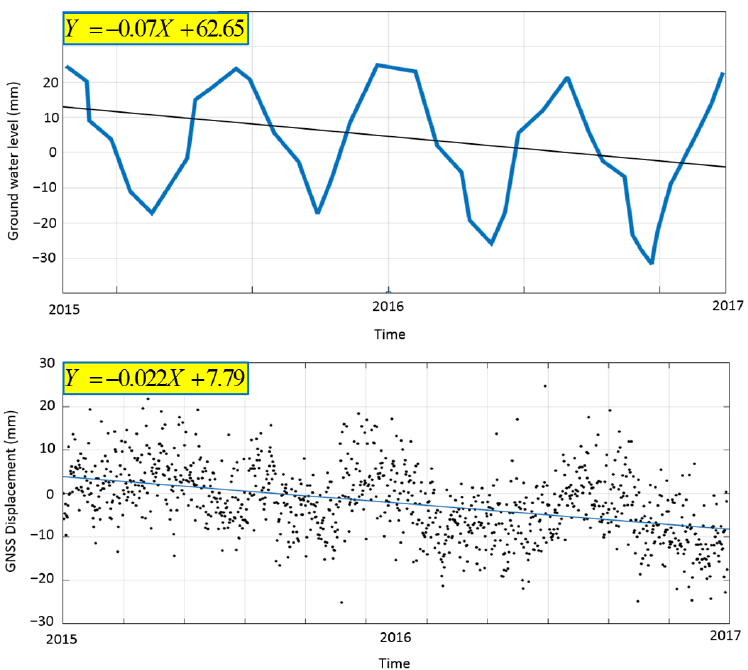
Figure 10. Comparison between the trend in the time series of groundwater levels obtained from GRACE data with linear fitting (( above ): black line) and the time series trend in the vertical compo- nent of the GNSS station (( below ): blue line).